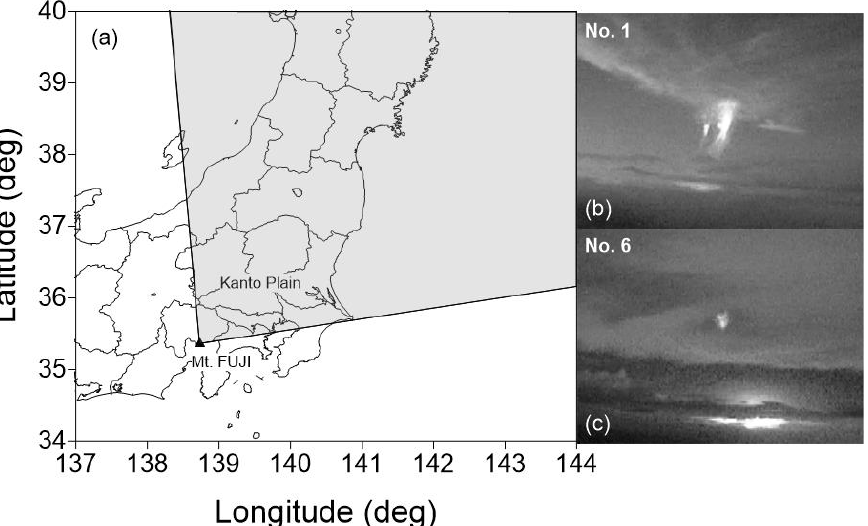
Figure 1. ( a ) Configuration of the TLE observations for the 2013 Mt. Fuji campaign and analysis area. The highlighted part is the TLEs area detectable from the summit of Mt. Fuji (marked as a black triangle) using a monochrome CCD camera; ( b ) and ( c ) are two of the six sprite images captured from the summit of Mt. Fuji on 22 July 2013.